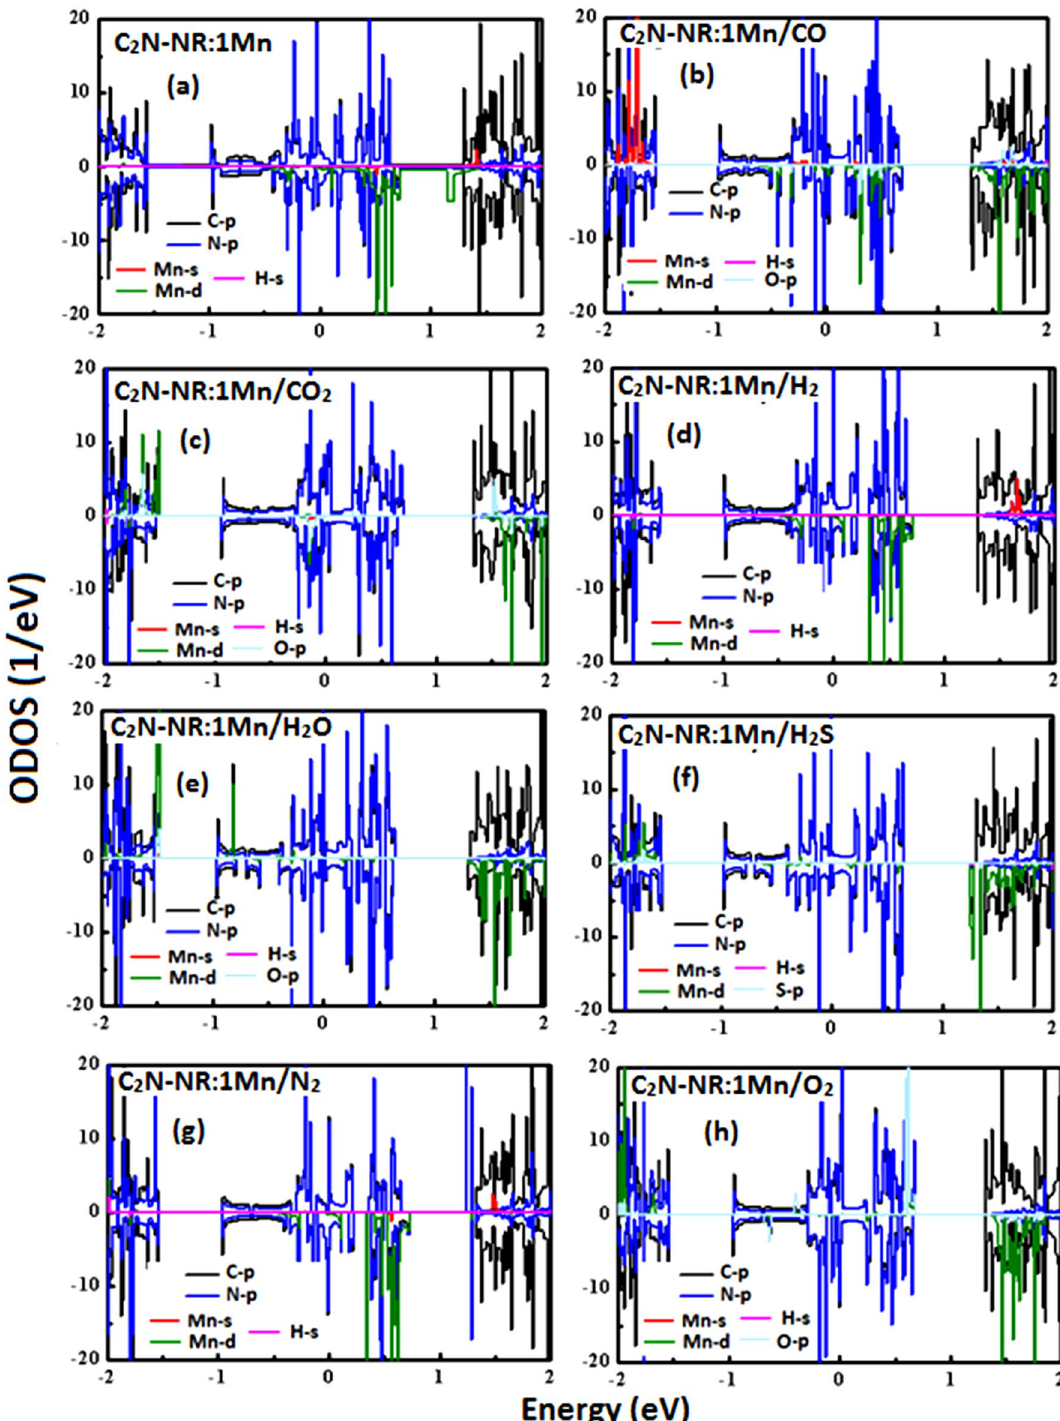
Figure. 5. Spin-polarized Orbital density of states (ODOS) for C 2 N-NR:Mn with various gas